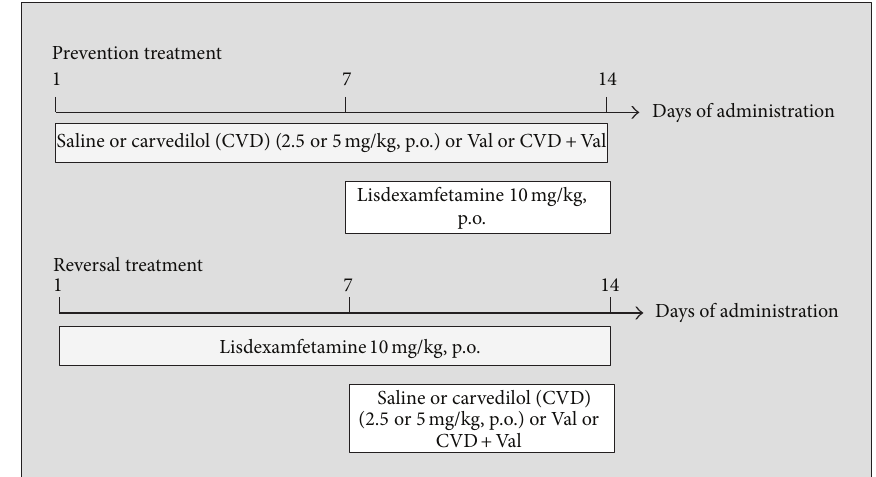
Figure 1: Schematic representation of the experimental